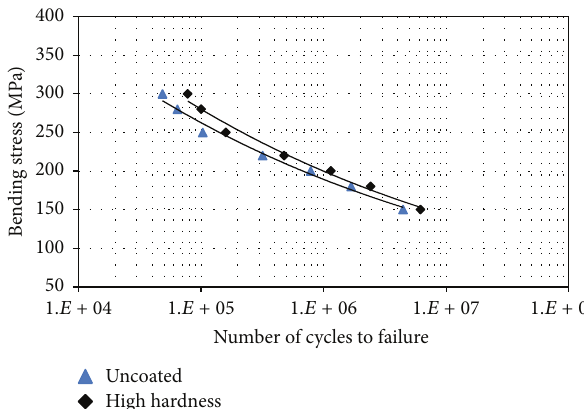
Figure 16: S/N curve of fretting fatigue for uncoated and TiN coated specimens with highest surface hardness [104].